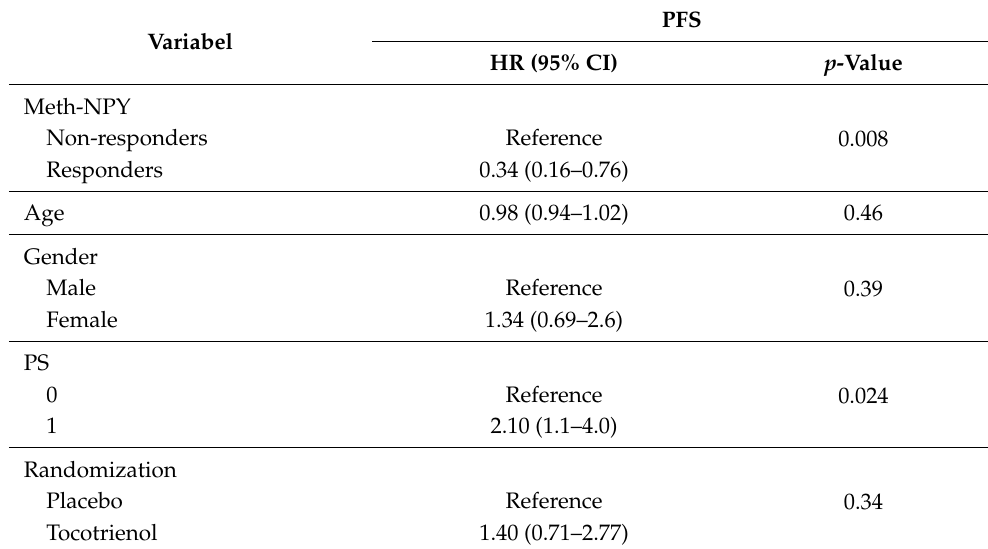
Table 2. Multivariate